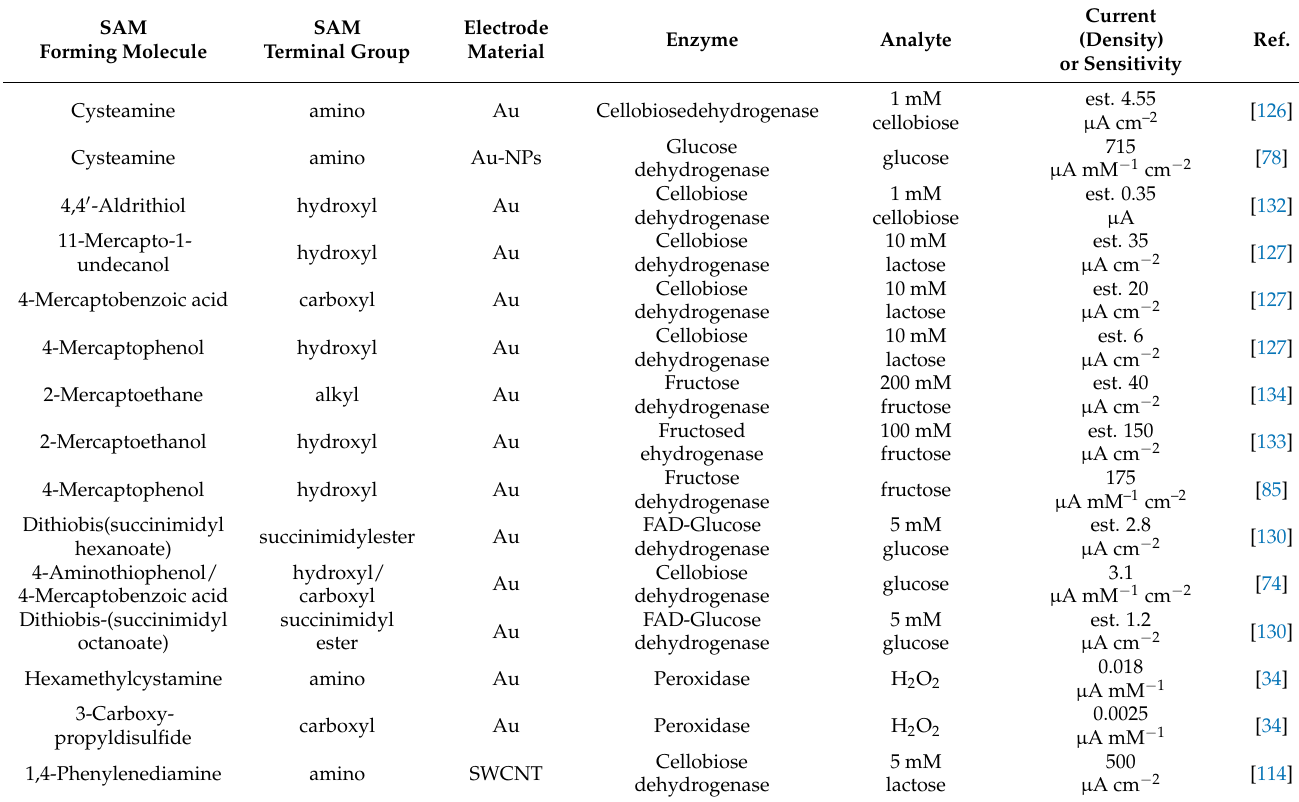
Table 2. Various SAMs applied for DET-based